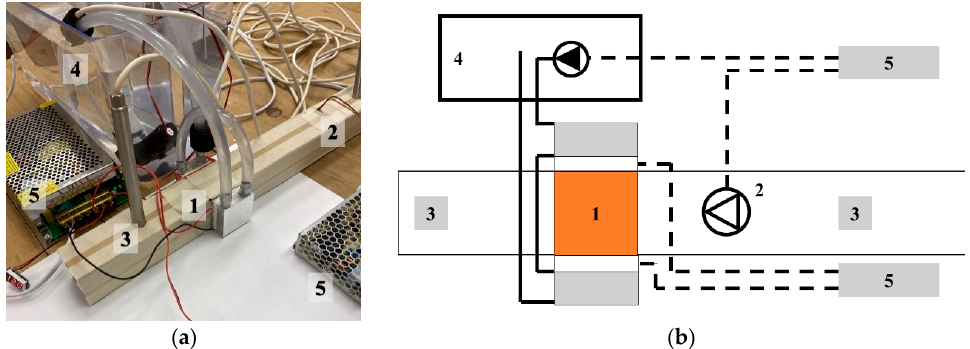
Figure 5. Arrangement (a) and scheme (b) of the measurement ((1) two water heat exchanger, heat sink and Peltier modules; (2) axial fan; (3) Thermometer; (4) Buffer tank; (5) Power supplies; continuous line: water pipe; dashed line: electric cable).